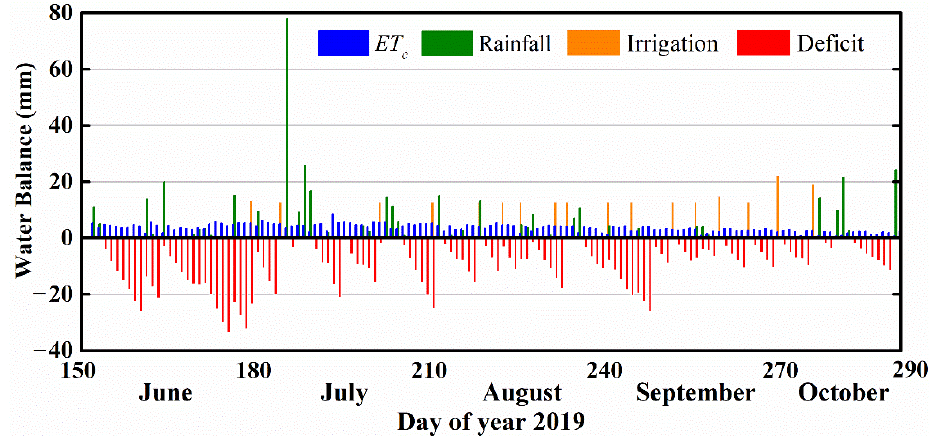
Figure 7. ET-based irrigation with ET c , irrigation, rainfall and water deficit.